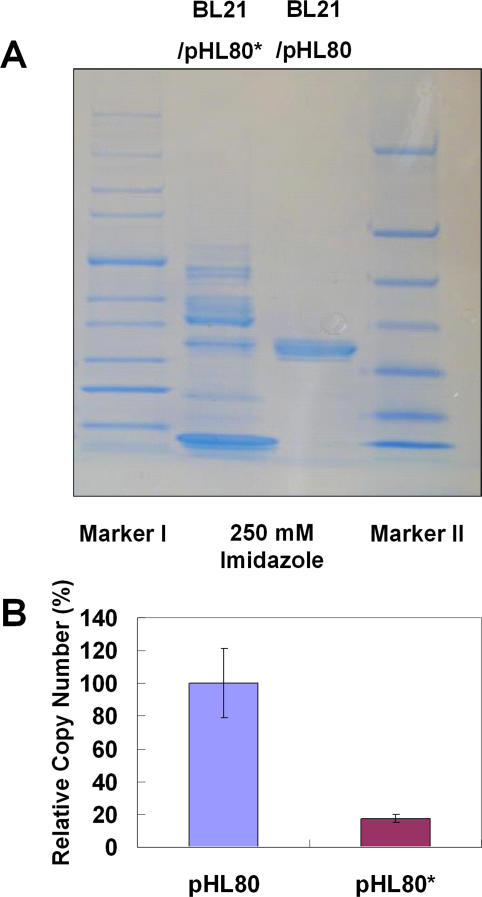
Analysis of the Mechanistic Basis for 6d-EryD Overproduction by Mutant A(A) SDS-PAGE analysis of Ni affinity-purified lysates of BL21/pHL80* and BL21/pHL80 following induction with 0.5 mM IPTG at 30 °C for 5 h.(B) The relative copy number of pHL80 and pHL80* in E. coli XL1-Blue.